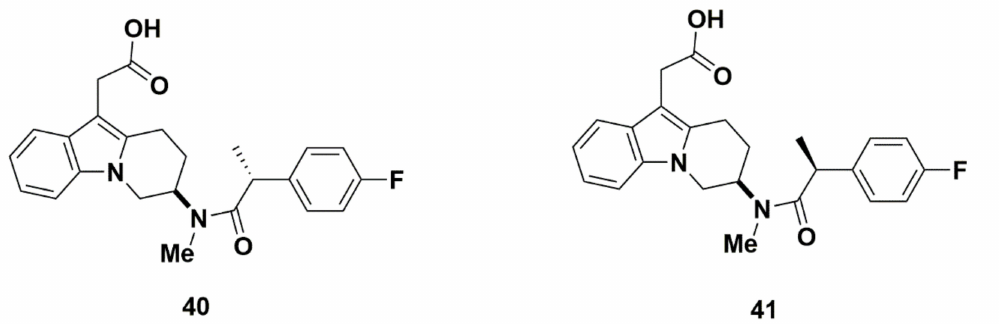
Figure 10. Molecular structures of compounds 40 and 41 . Table 2. Activities of azaindole sulfonamides and amides (values were obtained from [74]).